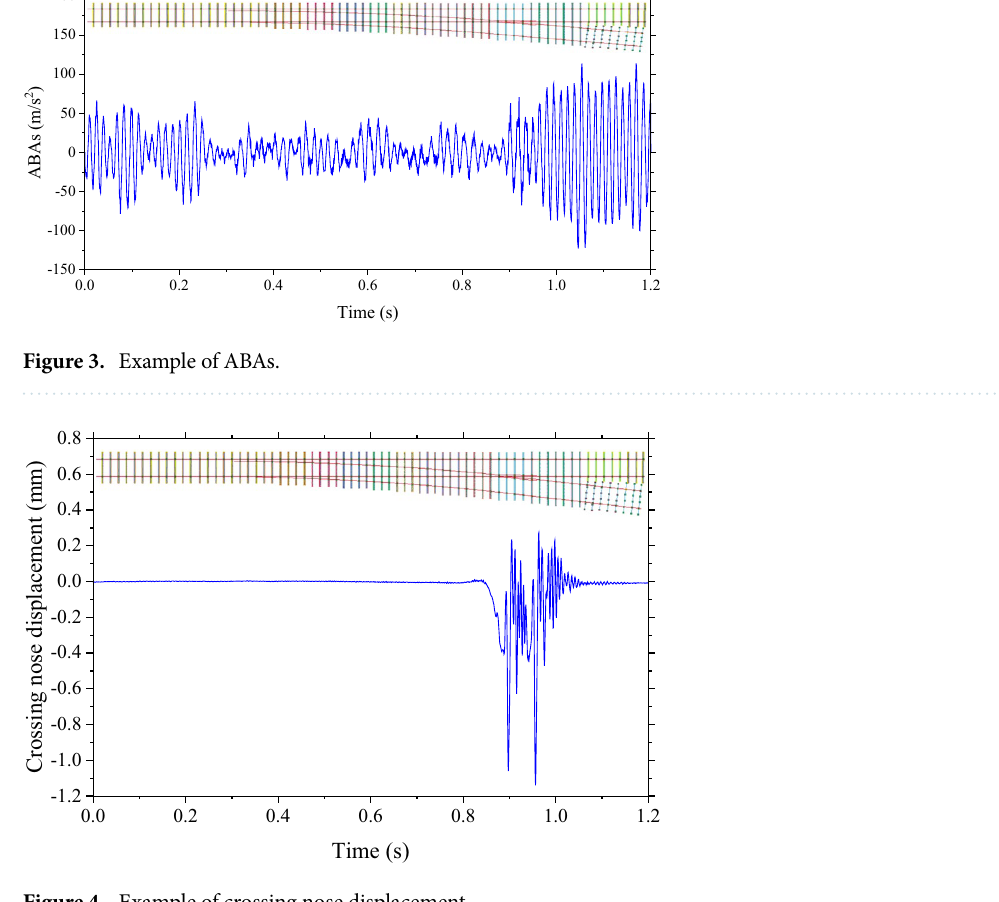
Figure 4. Example of crossing nose